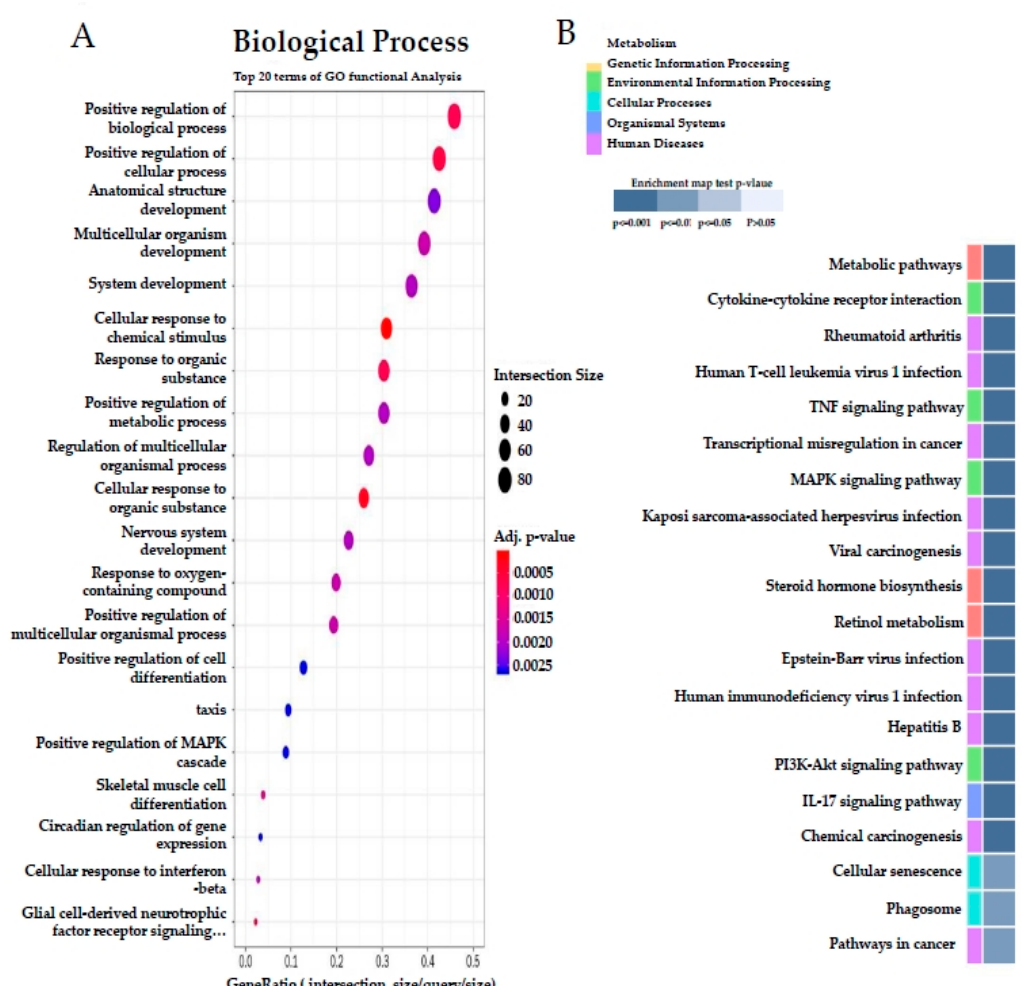
Figure 8. Effects of SQE on liver transcriptome profiles in HF-diet-fed rats. ( A ) Gene ontology (GO) analysis: Top twenty terms of GO function analysis in “biological process” are shown. ( B ) Kyoto Encylopedia of Genes and Genomes (KEGG) pathway analysis: Top twenty terms of KEGG pathway are shown. p value shown in modified Fisher`s exact test.